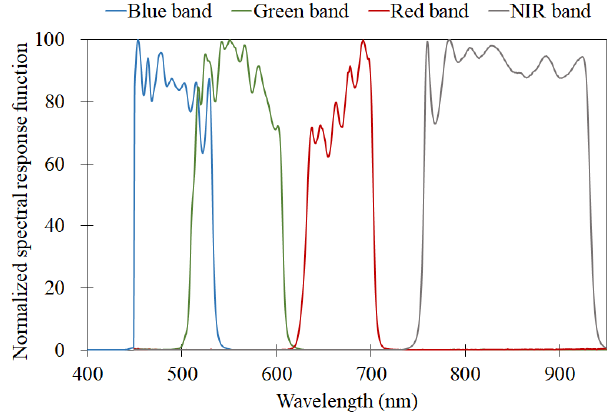
Figure 7. Relative spectral response function (SRF) for the blue, green, red, and near-infrared (NIR) spectral ranges of KOMPSAT-3 and -3A.